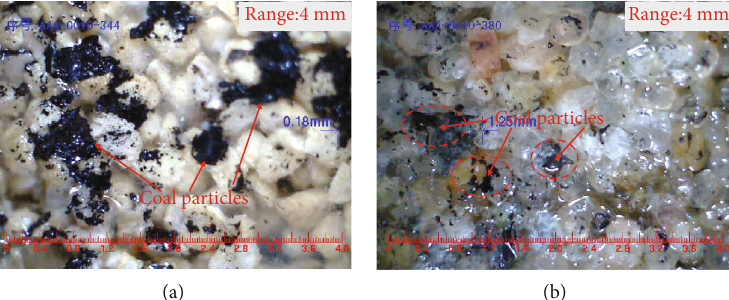
Figure 11: Distribution of pulverized coal particles in proppant pack. (a) Pulverized coal particles in ceramic proppant. (b) Pulverized coal particles in quartz sand